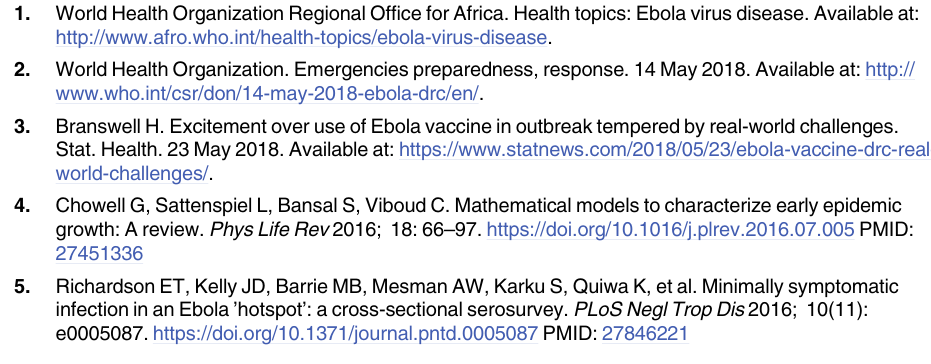
S2 Fig. Time-series of 18 prior Ebola outbreaks from 1976 to 2016 was depicted.